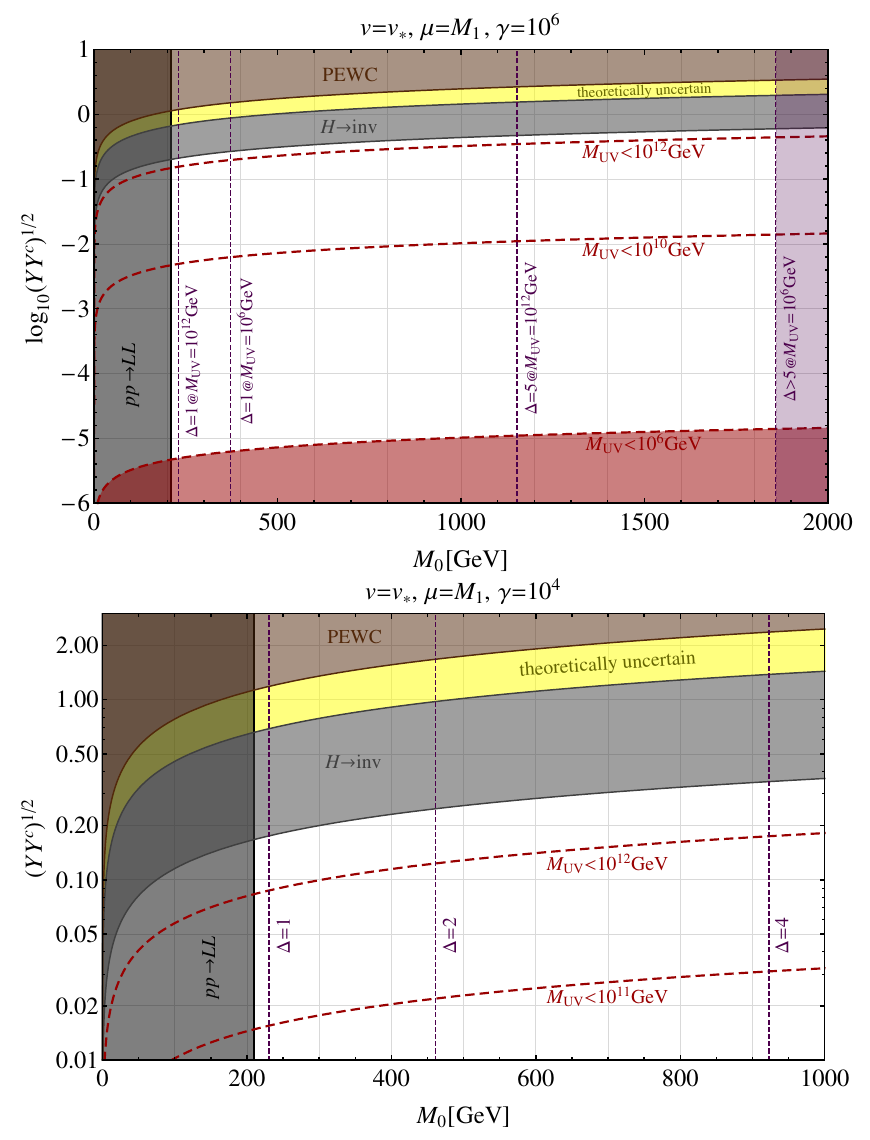
Figure 10 . Top panel: experimental and theoretical constraints on our model as a function of M 0 , assuming a critical Higgs vev v = v (cid:3) , (cid:22) = M 1 , and a warping factor (cid:13) = 10 6 throughout. Vertical contours (purple, dashed) show the (cid:12)ne tuning of M 1 as a function of M 0 . Theoretical lower limits on the Yukawa coupling ( Y Y c ) 1 = 2 are indicated by the red, dashed contours for M UV = 10 12 ; 10 10 ; 10 6 GeV. The dark gray shaded region on the left is excluded by LHC8 searches for f g the doublet leptons. The gray shaded band represents the limit on Higgs invisible decays, while the brown region near the top is excluded by precision electroweak constraints (PEWC); between them, there is an experimentally allowed yellow region where the functionality of our mechanism is unclear. Bottom panel: zoom on a region with larger Yukawa couplings and smaller M 0 , and for a smaller warping factor of (cid:13) = 10 4 instead. Vertical tuning contours (purple, dashed) of (cid:1) = 1 ; 2 ; 4 are for M UV = 10 12 GeV, while the theoretical lower limits (red, dashed) on the Yukawa coupling in our model are now shown for M UV = 10 12 GeV and 10 11